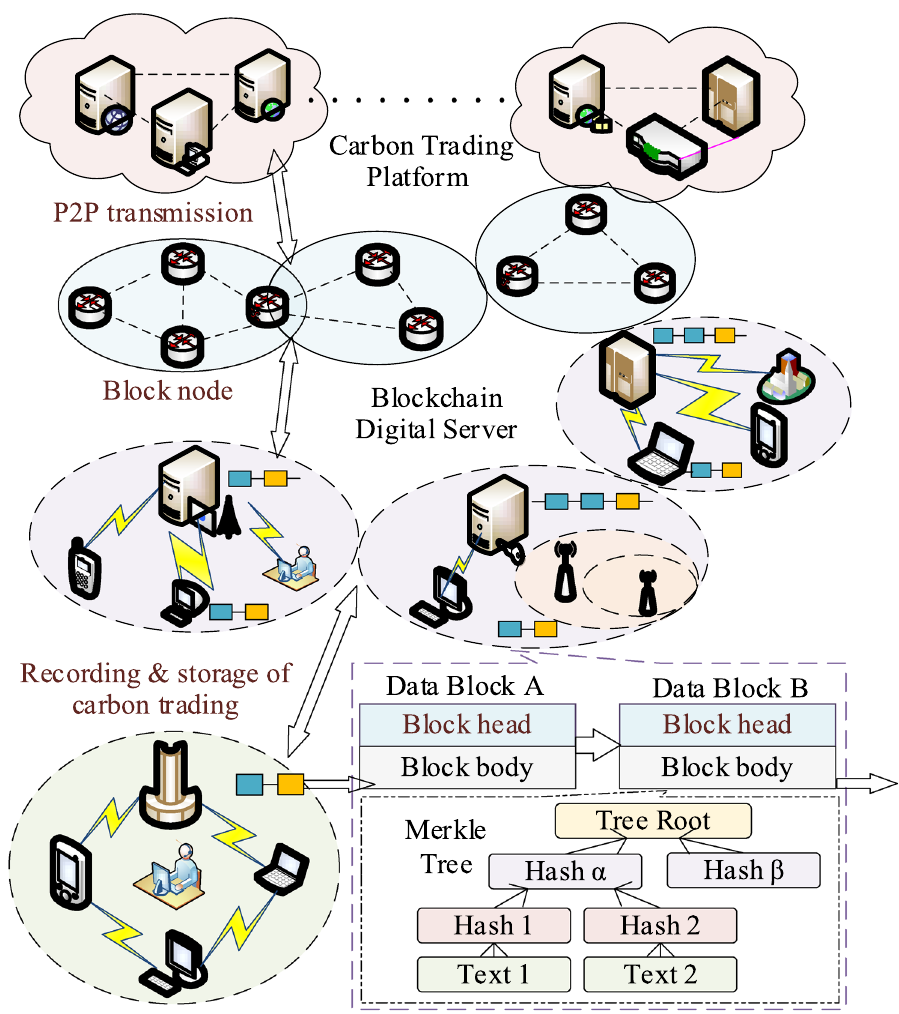
Figure 9. Framework of carbon trading platform based on